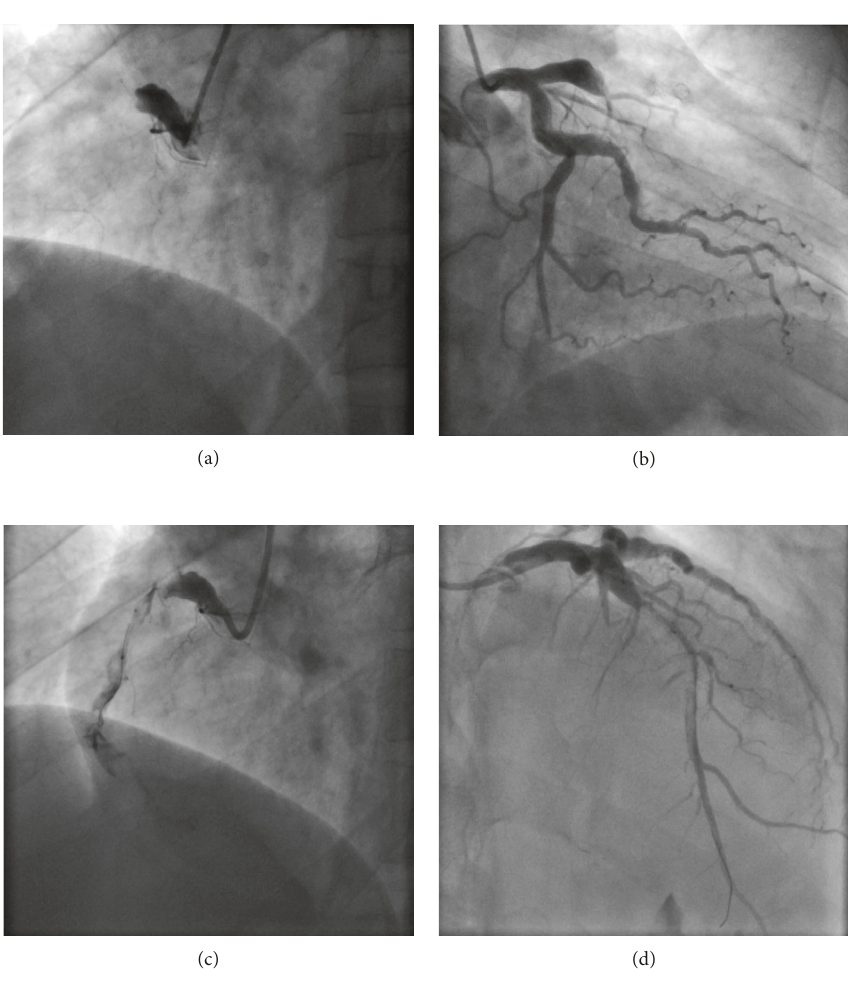
Figure 2: Coronary angiography. Marked ectasia and proximal occlusion of right coronary artery (a) and left anterior descending coronary artery (b). After initial ballon angioplasty, both vessels showed extensive thrombus burden and flow restriction (c and d).